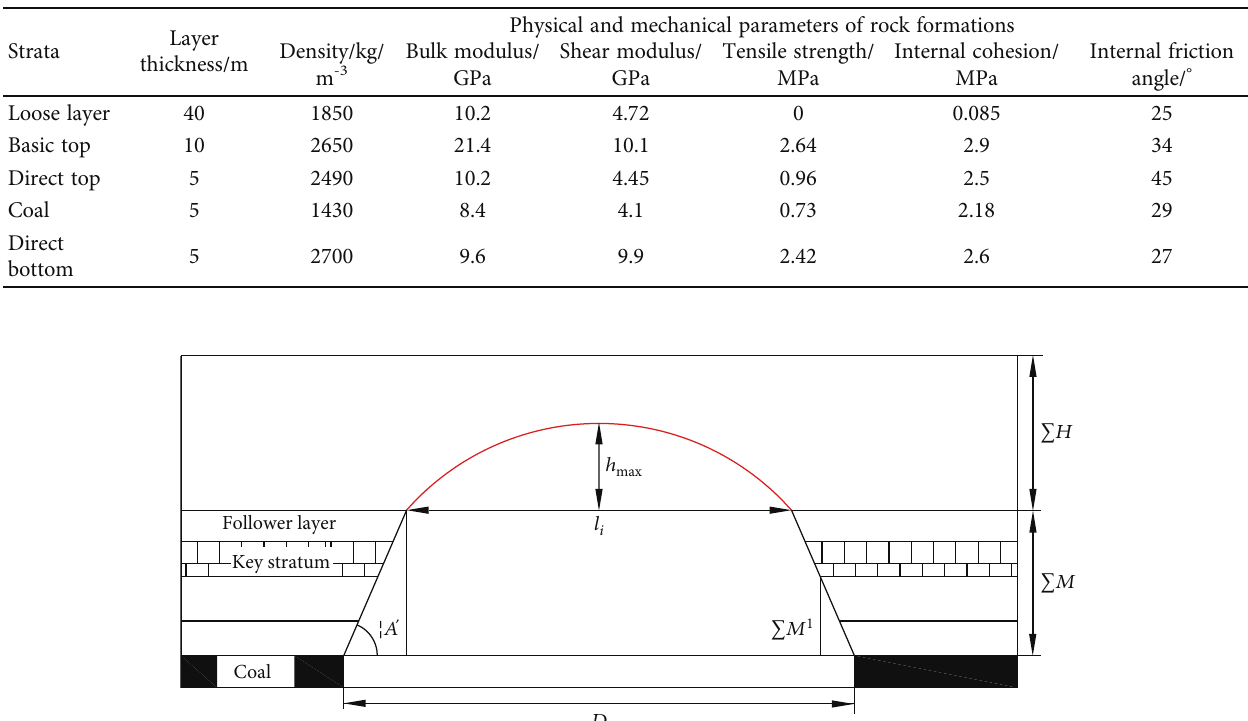
Table 1: Mechanical parameters of rock mass and joints.